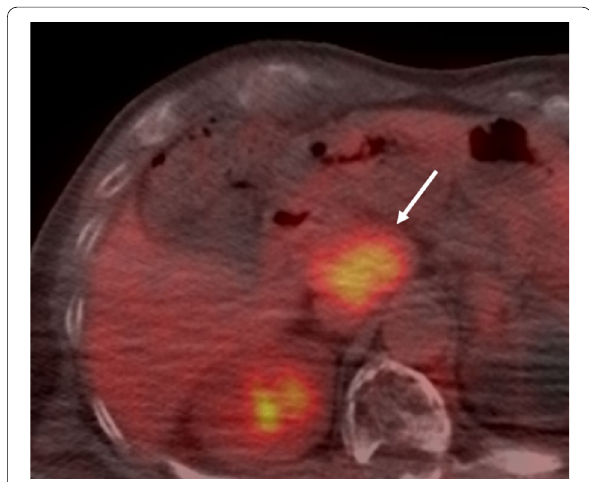
Fig. 3 Positron emission tomography findings. The PET revealed localized accumulation of fludeoxyglucose (5.9 F) in the